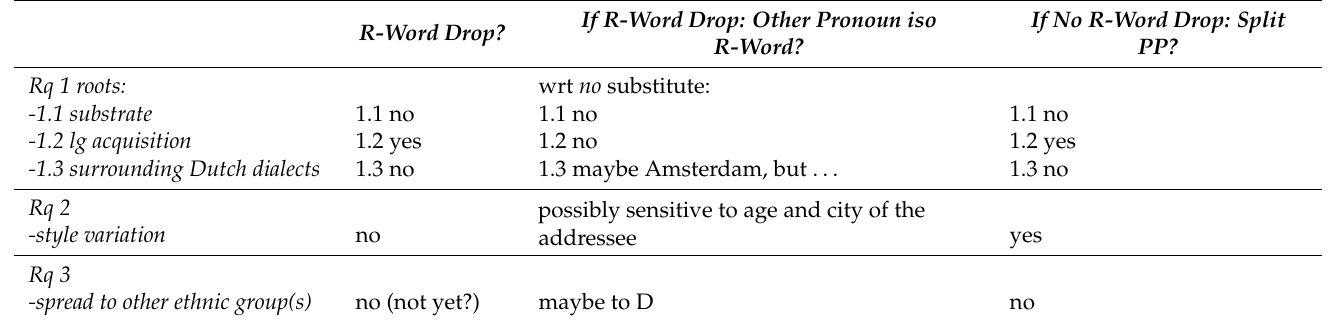
Table 8. Answering the research questions on the basis of the findings for the R-pronouns; three dimensions of